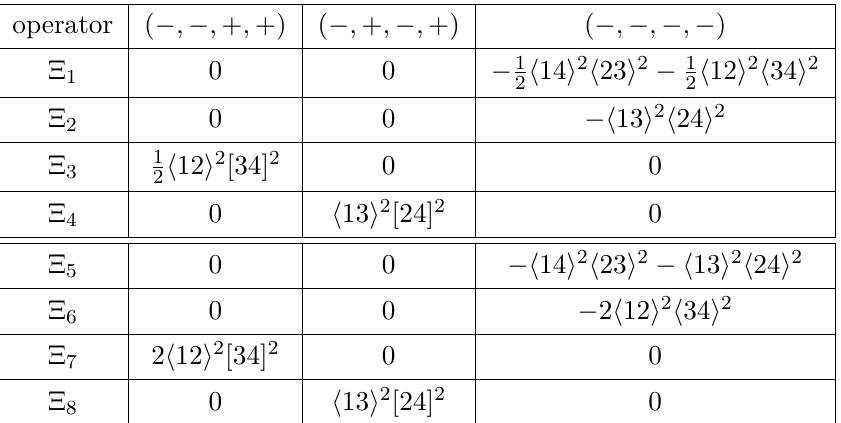
Table 7 . Color-ordered tree-level minimal form factors of length-4 operators at dimension 8. The color factors are tr(1234) and tr(12)tr(34) for single and double trace operators,